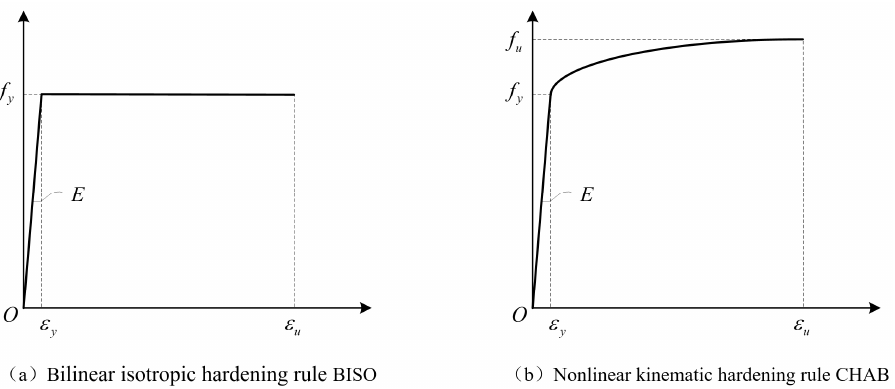
Figure 10. The material constitutive relationships for steel components in the FE models of CSA-BRBs.